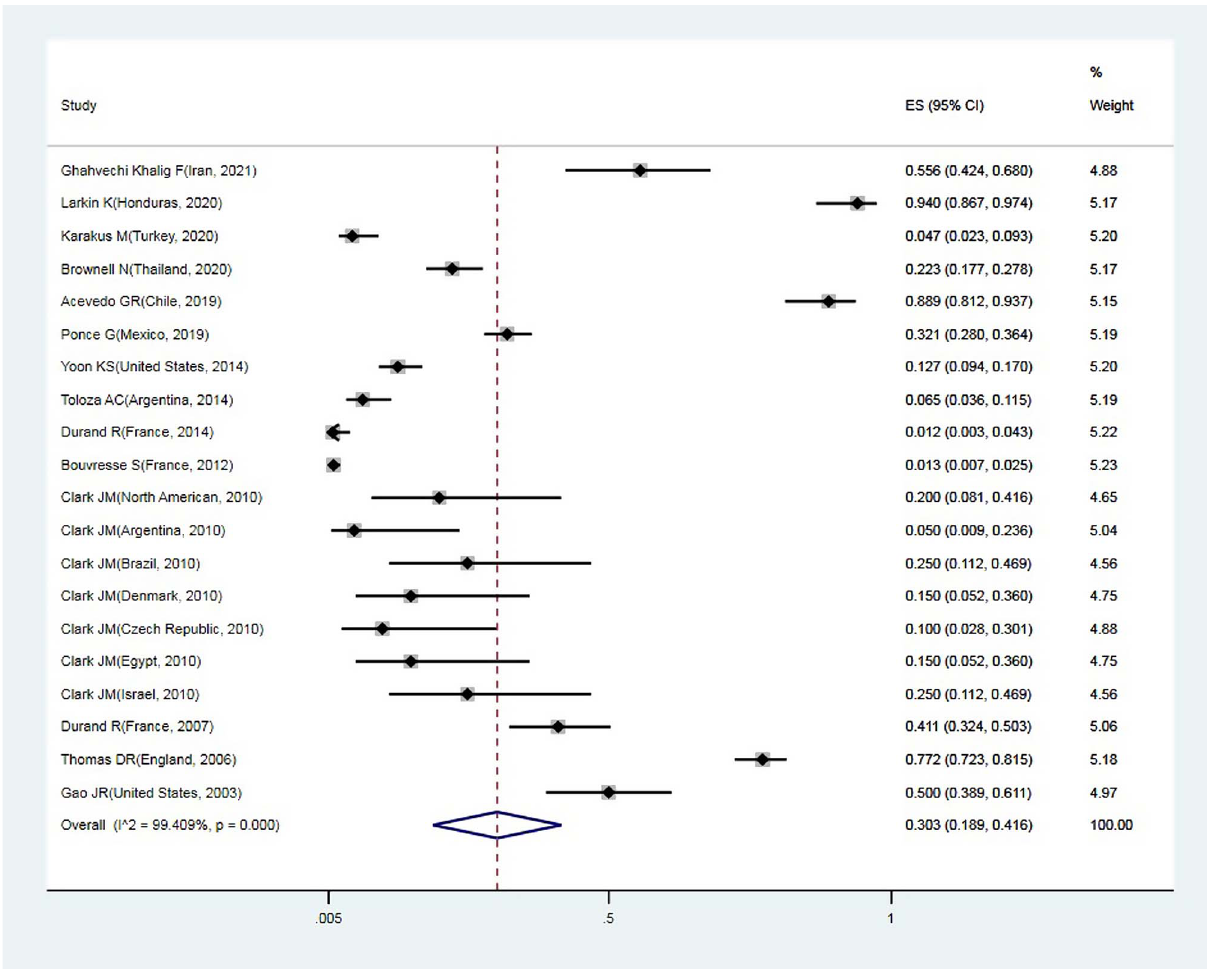
Figure 4. Forest plots of the proportion of heterozygote resistance and 95% con fi dence interval based on a random effect model in meta- analysis.